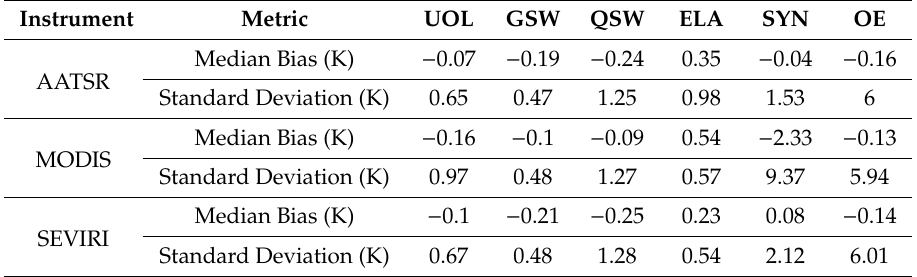
Table 4. The median bias and standard deviation for the different thermal infrared algorithms applied to the AATSR, MODIS and SEVIRI instruments.